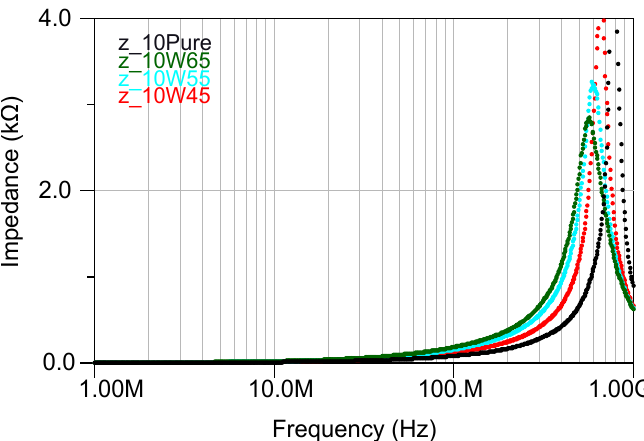
Figure 10. Impedance of the inductors with 10 turns having cores with different percentage of the magnetic powder. Z_10 pure is the inductor with a core made out of the pure epoxy, Z_ 10WY is the impedance of inductors having a core made out of Y% of the magnetic powder mixed with the epoxy.